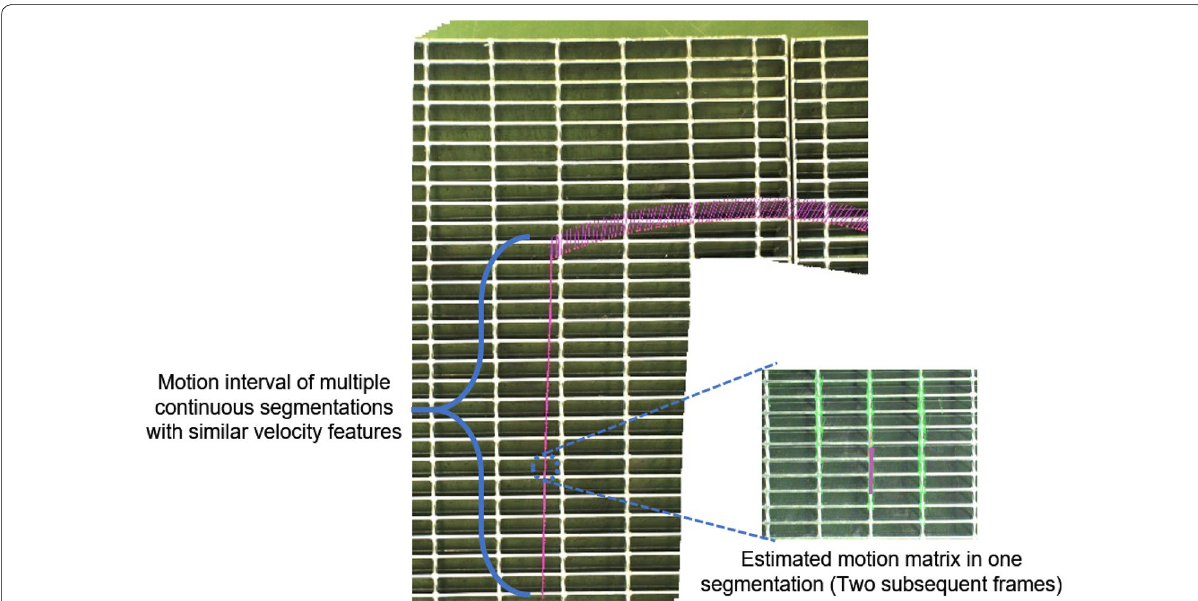
Fig. 7 Concept of segmentation and motion interval used in the compensation method (the green points and lines in the segmentation indicate the feature points and matching relationship; the purple lines indicate the instant camera poses, forming a jagged shape when